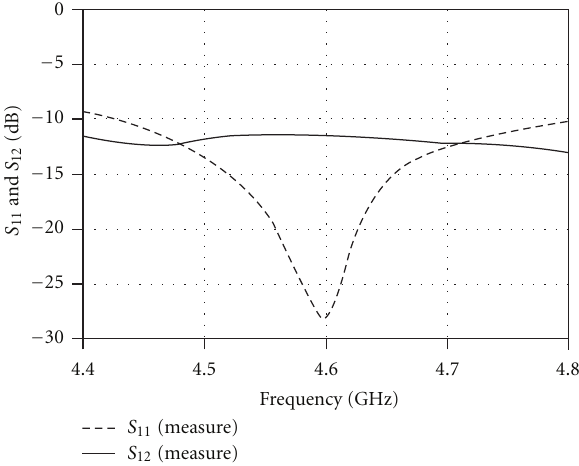
Figure 8: Measured MIMO antenna input reflection and coupling ( S 11 and S 21 ) for dipoles on edges.